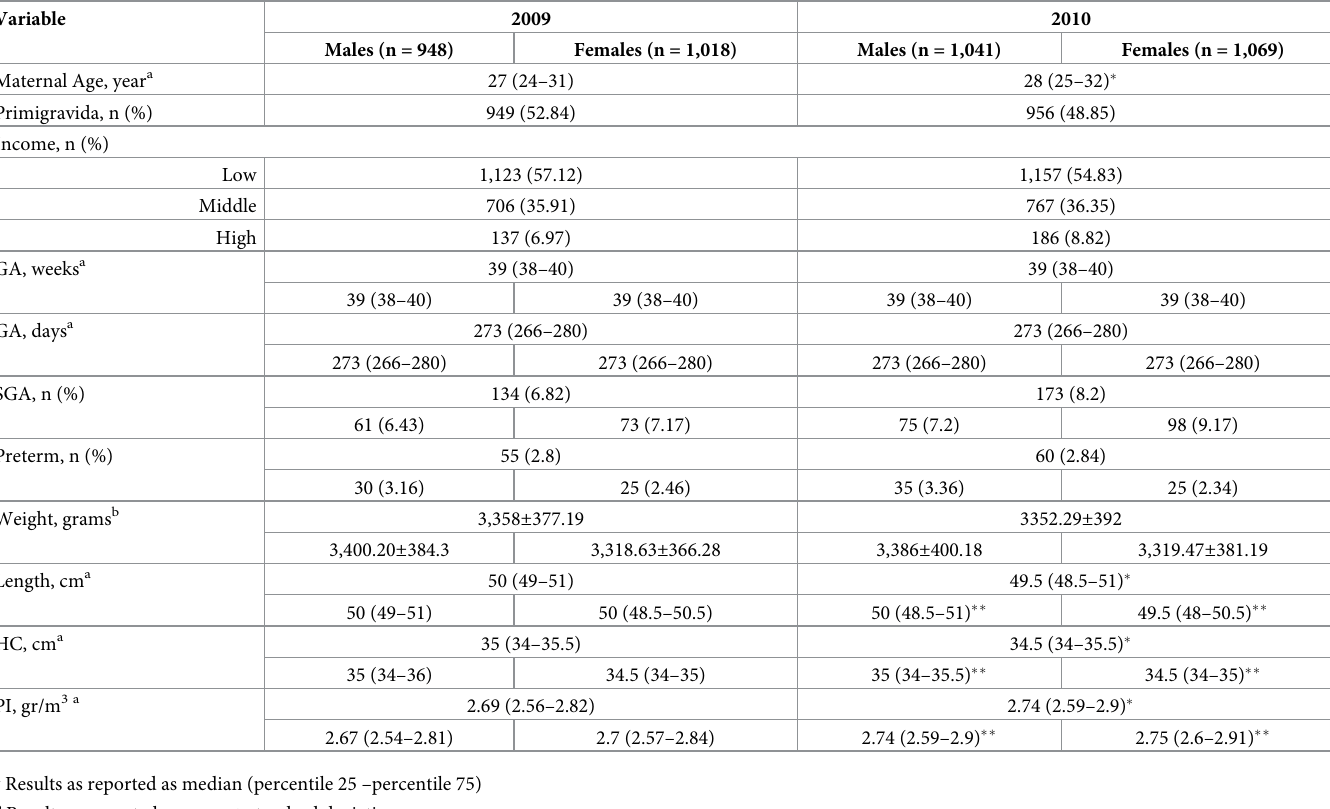
Table 1. Maternal and newborn characteristics and perinatal outcomes by year and gender.